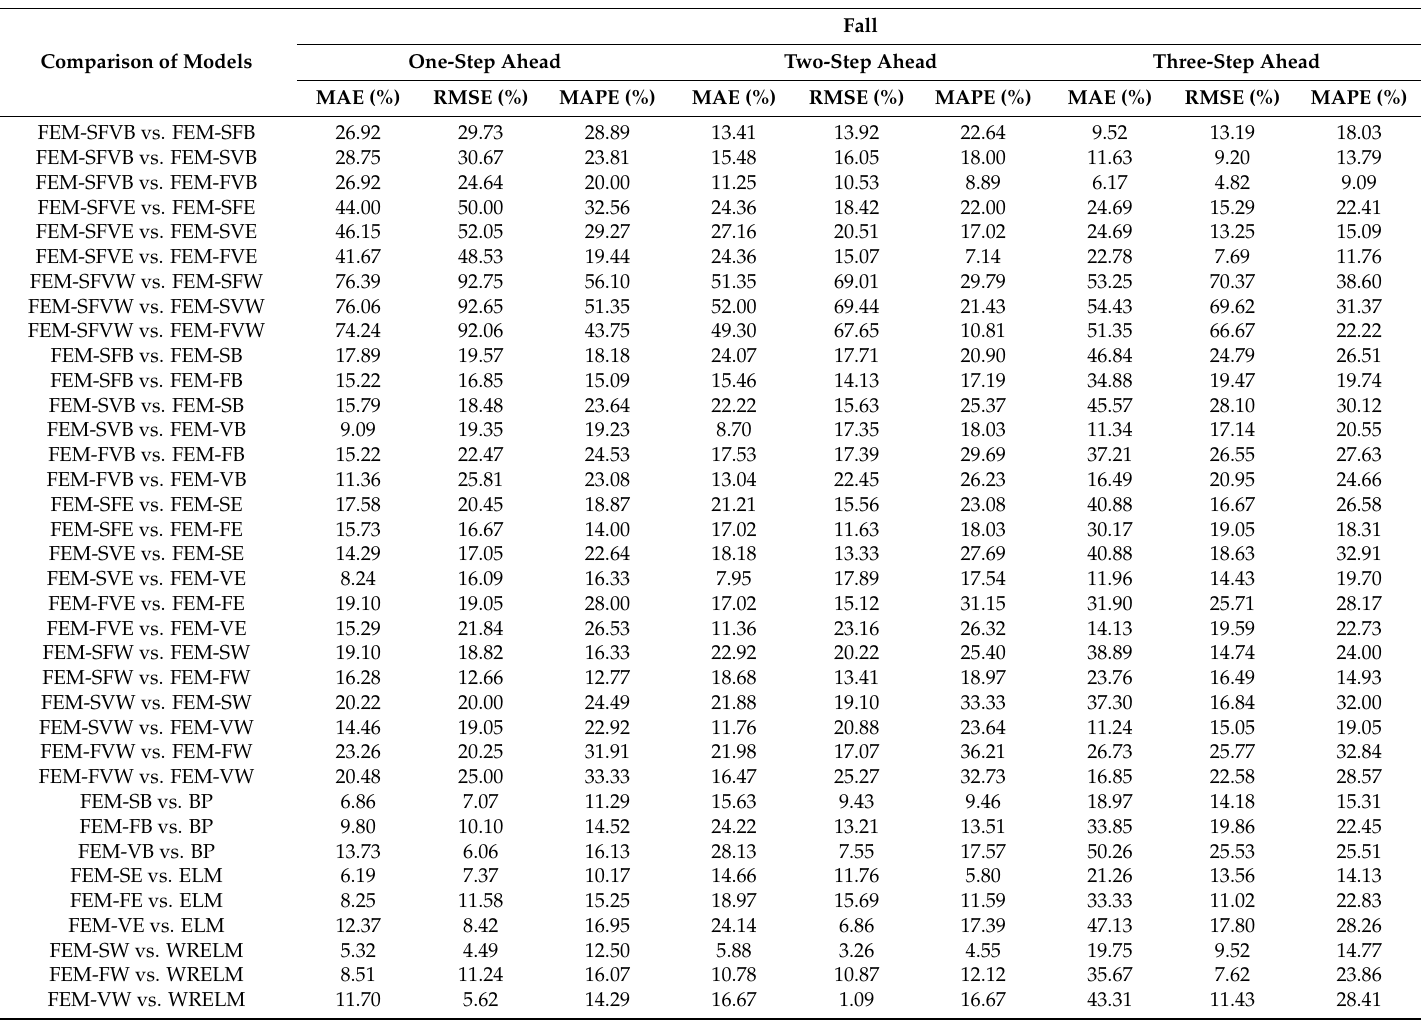
Table 13. Comparison results of experiments III, IV and V in